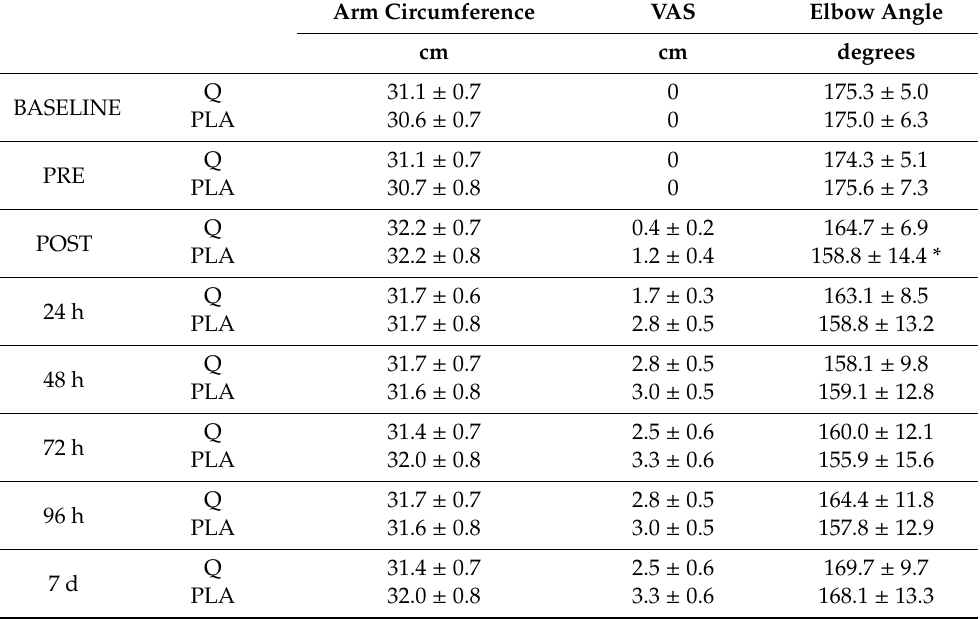
Table 2. Arm circumference, visual analogue scale (VAS) of perceived pain and elbow angle in Q and PLA before, after the EEIMD and during the recovery.